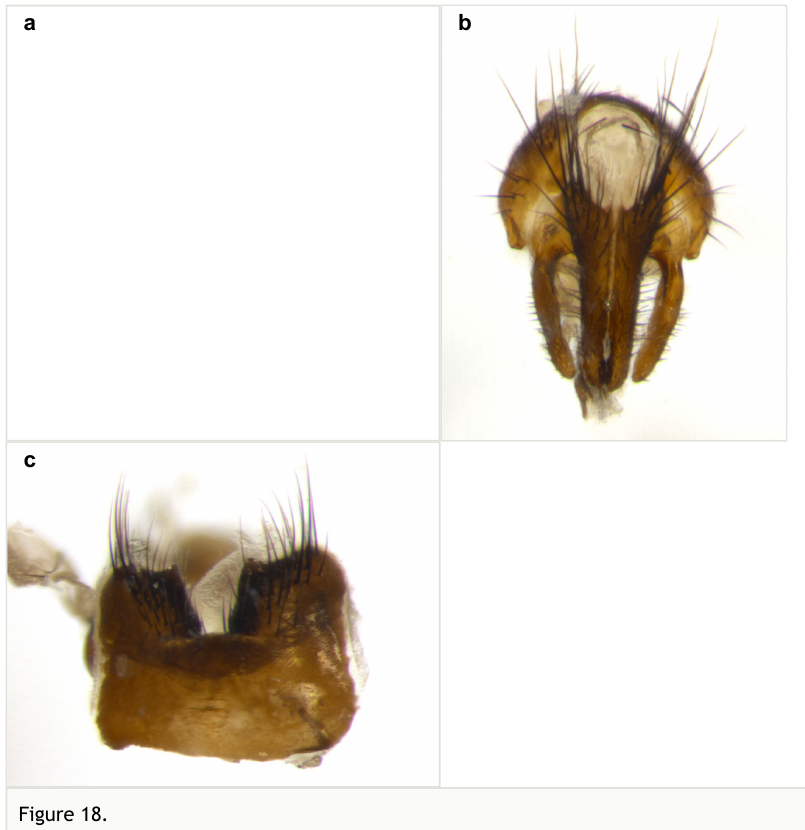
Male terminalia of Calolydella felipechavarriai sp. n. ; a–c : paratype, voucher n.